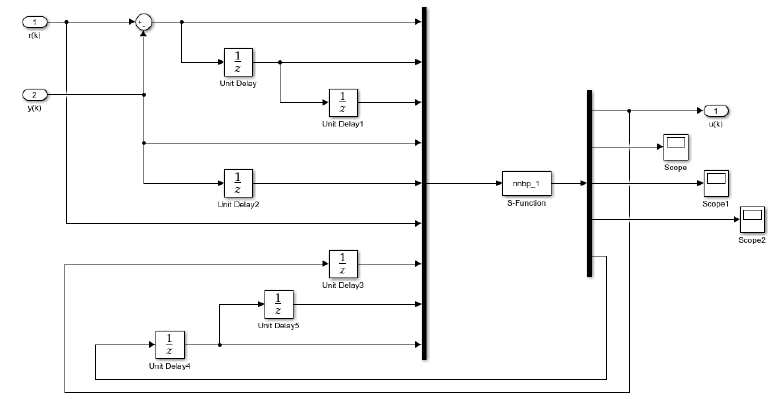
Figure 16. BP_ Build simulation model of PID controller.